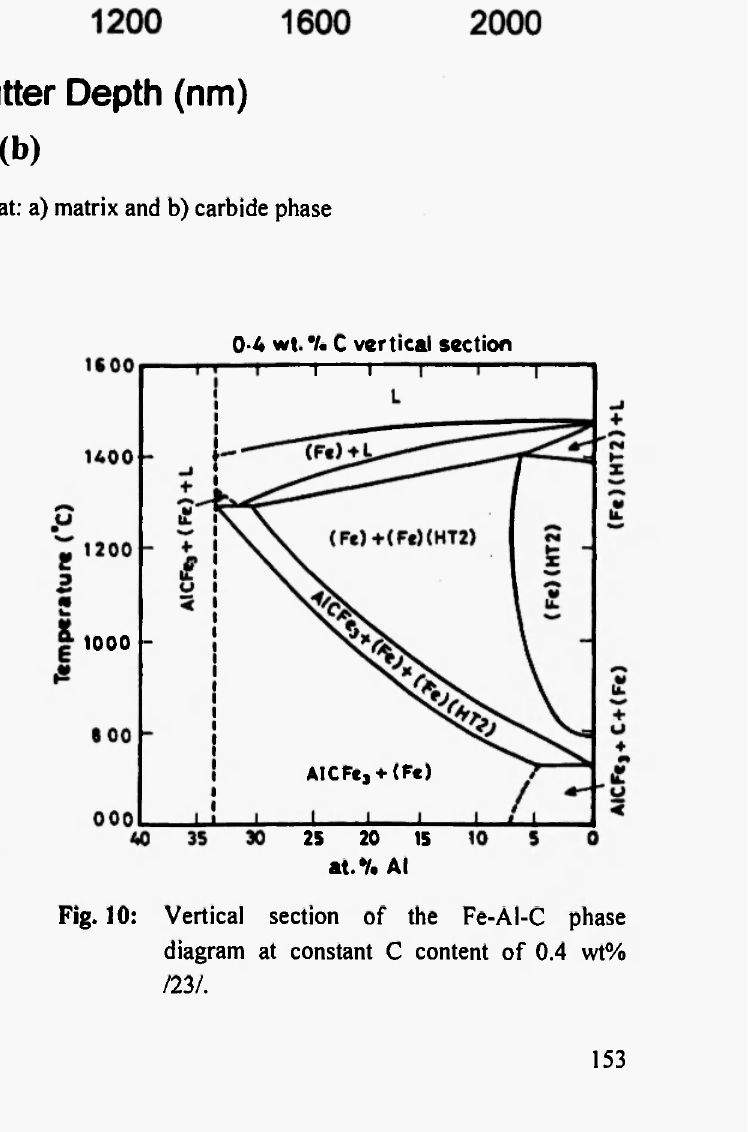
Fig. 9: AES depth profiles at: a) matrix and b) carbide phase